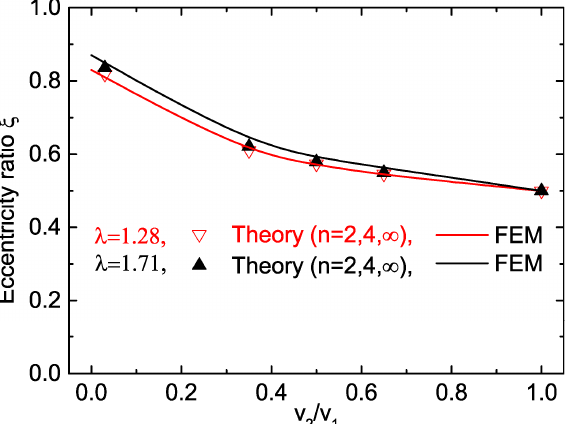
Figure 4. Comparison of the analytical and simulated eccentricity ratio ξ at different velocity ratios and extrusion ratios (room temperature).